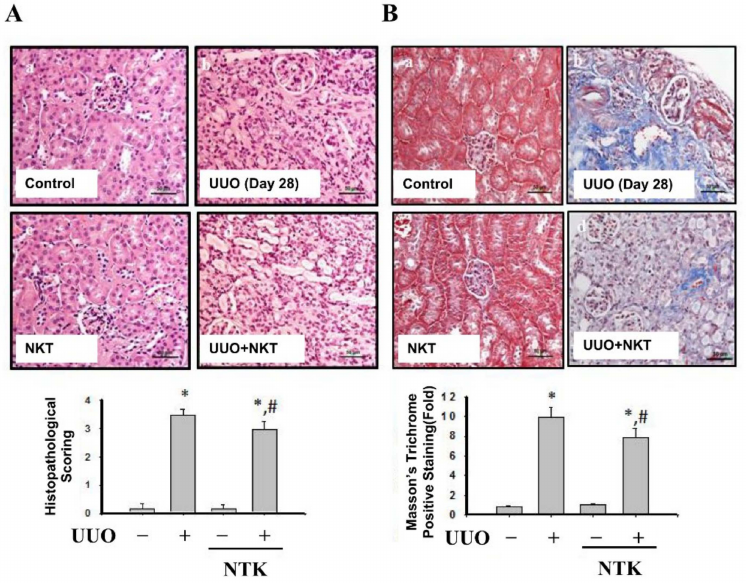
Figure 3. Effects of Nootkatone treatment on the renal pathological changes and collagen deposition in a UUO mouse model. Vehicle or Nootkatone (NKT) was orally given to the sham or UUO mice for 28 days. The pathological changes determined by H&E staining ( A ). The collagen deposition was determined by Masson’s trichrome staining ( B ). Scale bar: 50 µ m. Data are presented as mean ± SD ( n = 6). * p < 0.05 vs. the sham control group. # p < 0.05 vs. the UUO